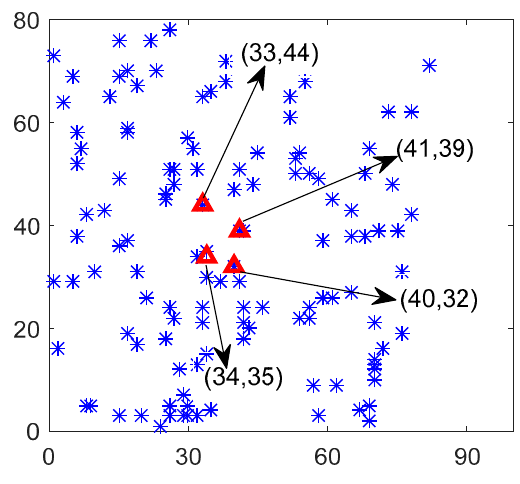
Figure 5. Selection of Starting Point for Vehicles. Table 3. Proportions of distance priority α and routing hop priority β .